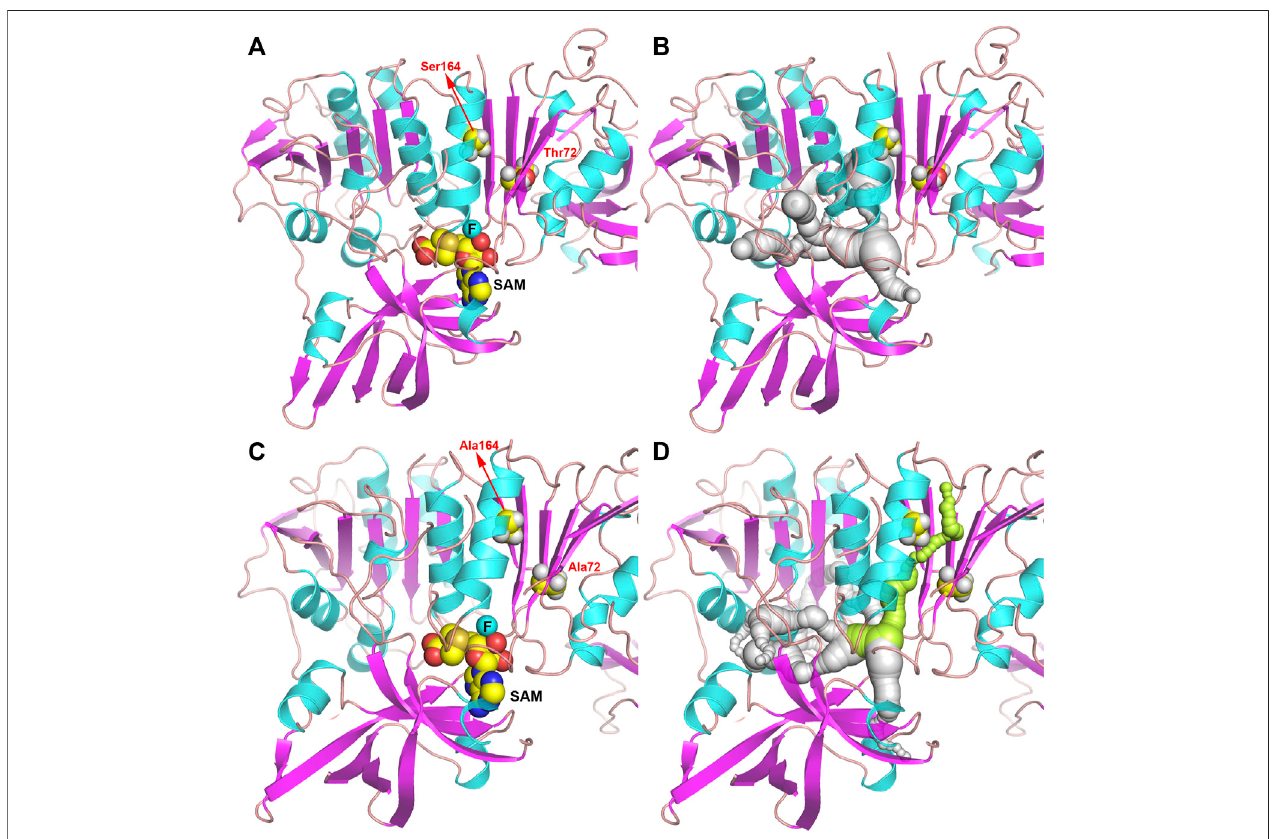
FIGURE 5 | Structure of Fam shown as ribbon. (A,B) Fam-WT. (C,D) Fam-T72A/S164A. The pathway for the substrate to enter the active site is shown in gray and green.